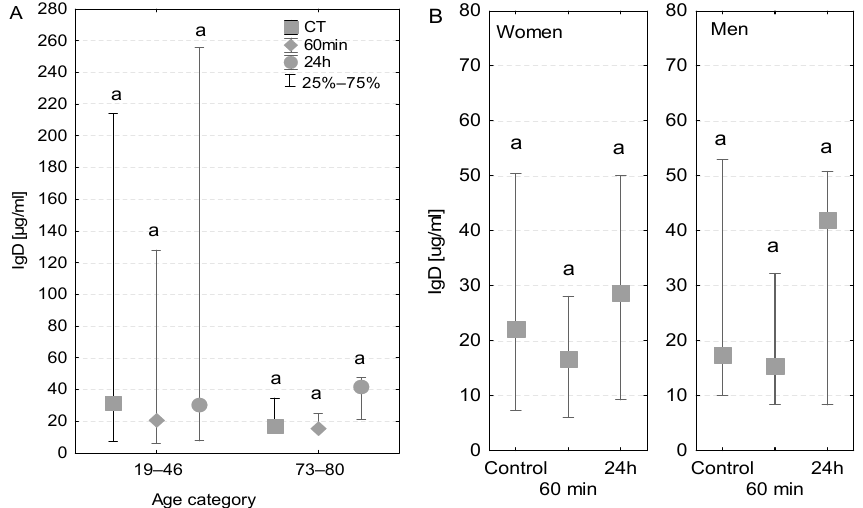
Figure 4. Serum IgD concentration (median ± quartile deviation; 25th and 75th percentiles). ( A ) Comparison based on the age of patients: 19–46 years and 73–80 years. ( B ) Comparison based on the sex of the patients. CT: measurement before the onset of CPB; 60 min: measurement at 60 min of the CPB onset; 24 h: measurement at 24 h after the onset of CPB. The same letters (a) indicated no statistical differences within age or sex category (Friedman’s or Mann–Whitney U test; p < 0.05.).